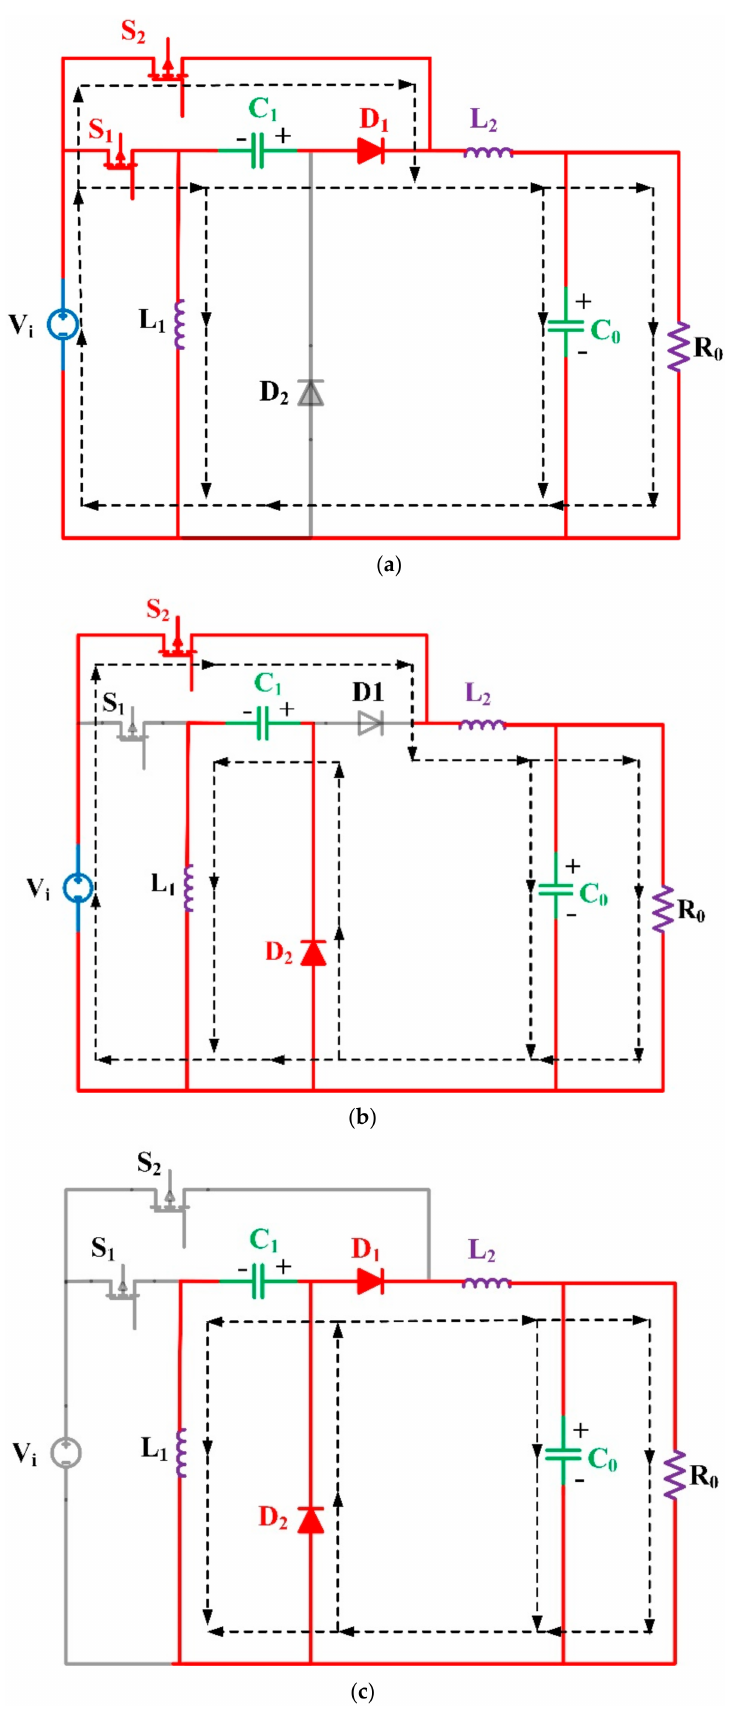
Figure 3. The proposed hybrid Zeta converter equivalent circuits. ( a ) Mode-1 ( b ) Mode-2 ( c )